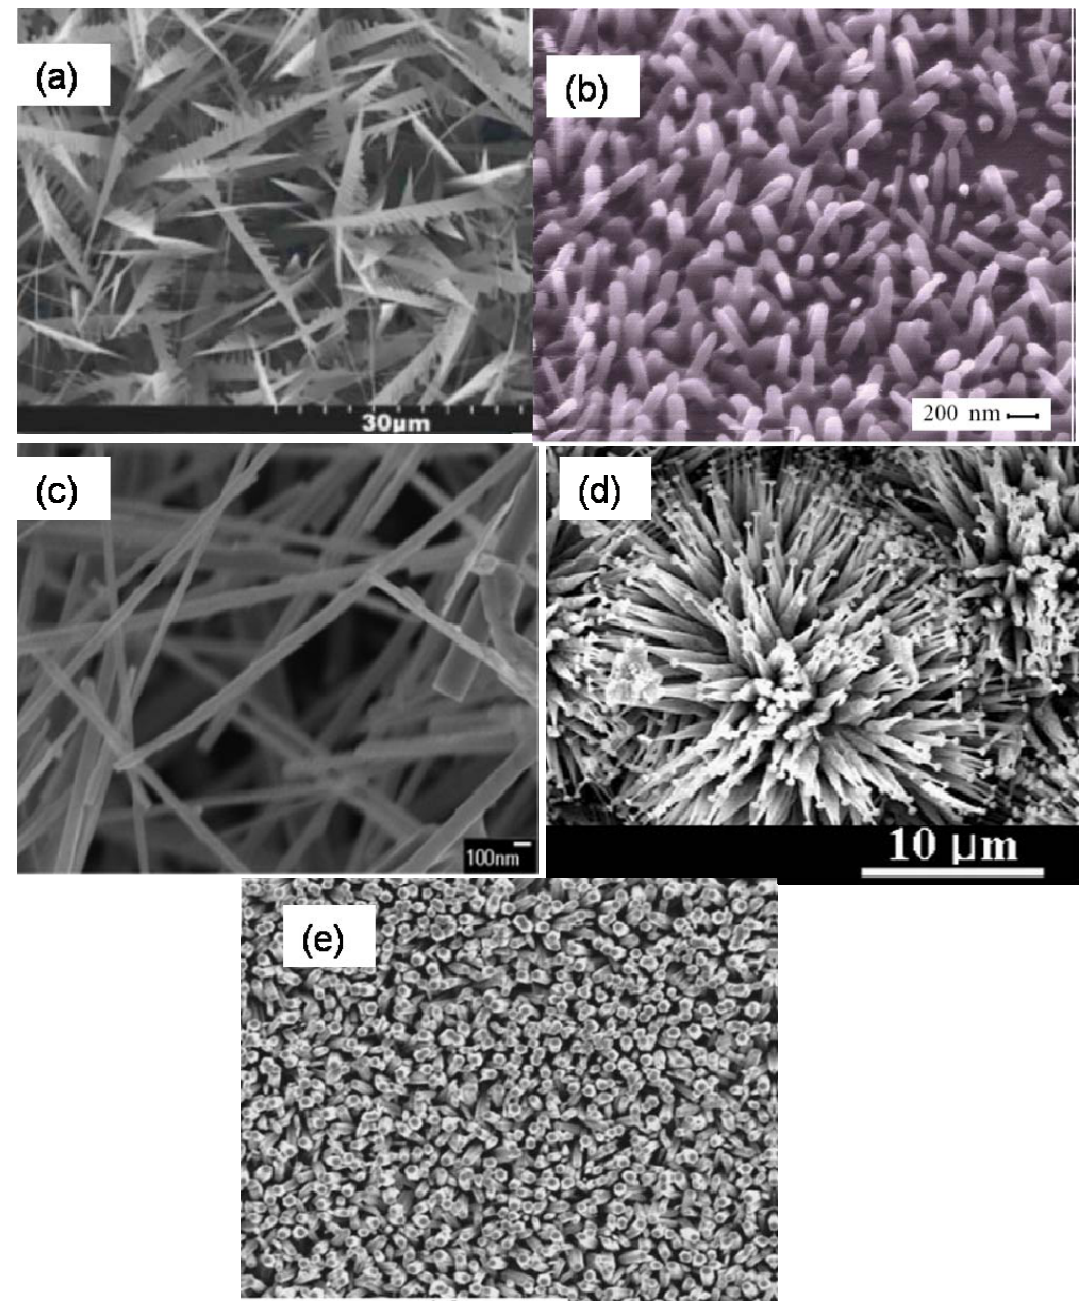
Figure 1. ZnO nanostructure materials with various shapes: (a) nanocombs made by vapor- phase-transport [13]; (b) nanowires obtained by vapor-liquid-solid [14]; (c) nanowires made by thermal evaporation [15]; (d) nanonails made by thermal evaporation [16]; (e) nanorods obtained by hydrothermal decomposition